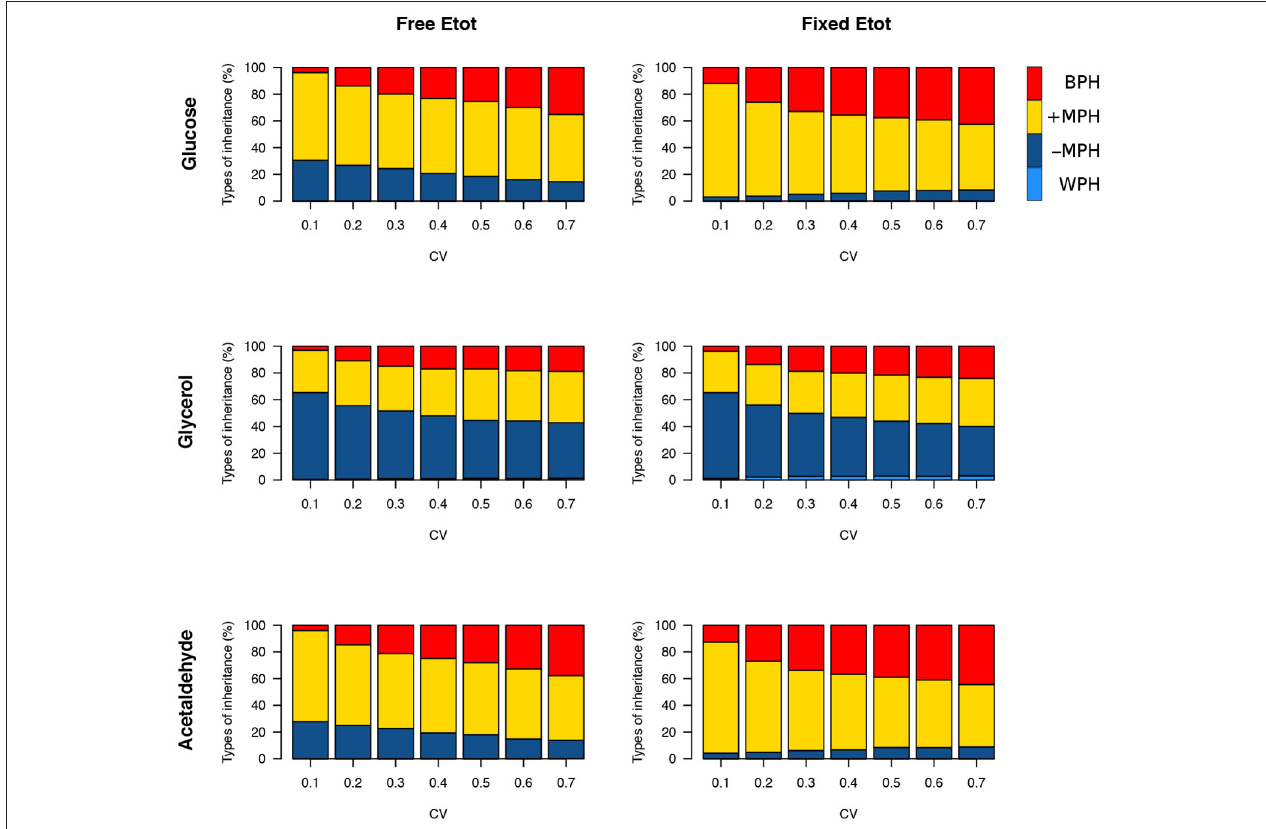
FIGURE 10 | Heterosis for the three fluxes in the glycolytic/fermentation network. Percentages of different types of inheritance over the 0.1–0.7 c v range of parental enzyme concentrations, for free and fixed E tot .